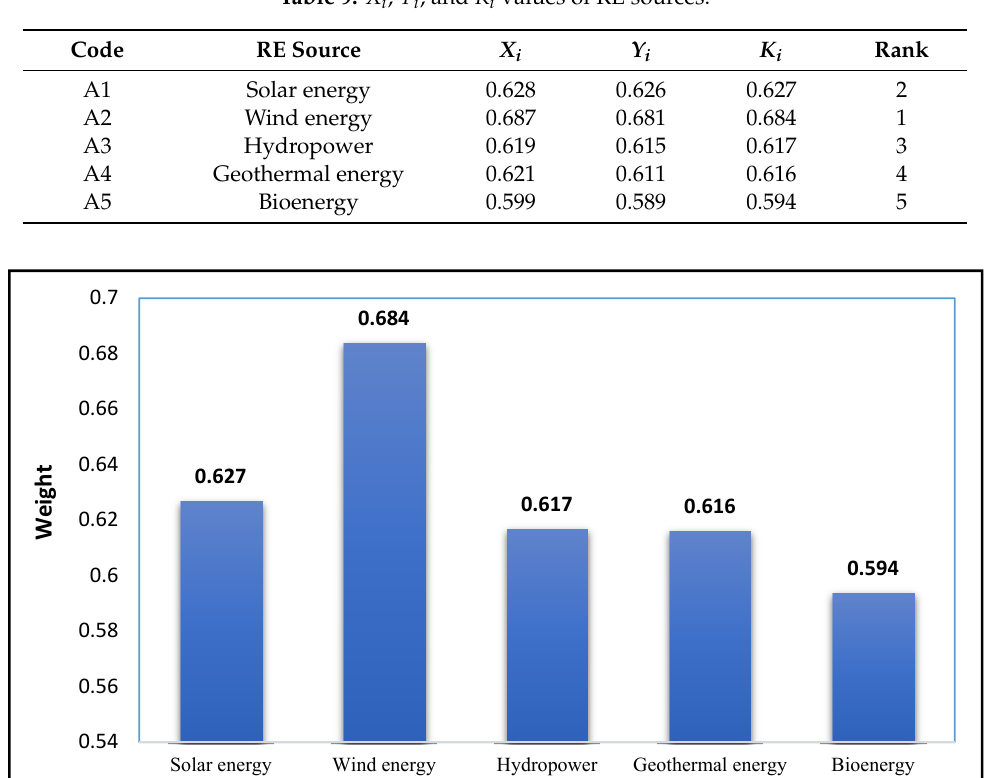
Figure 4. The final ranking of RE sources based on the highest value of K